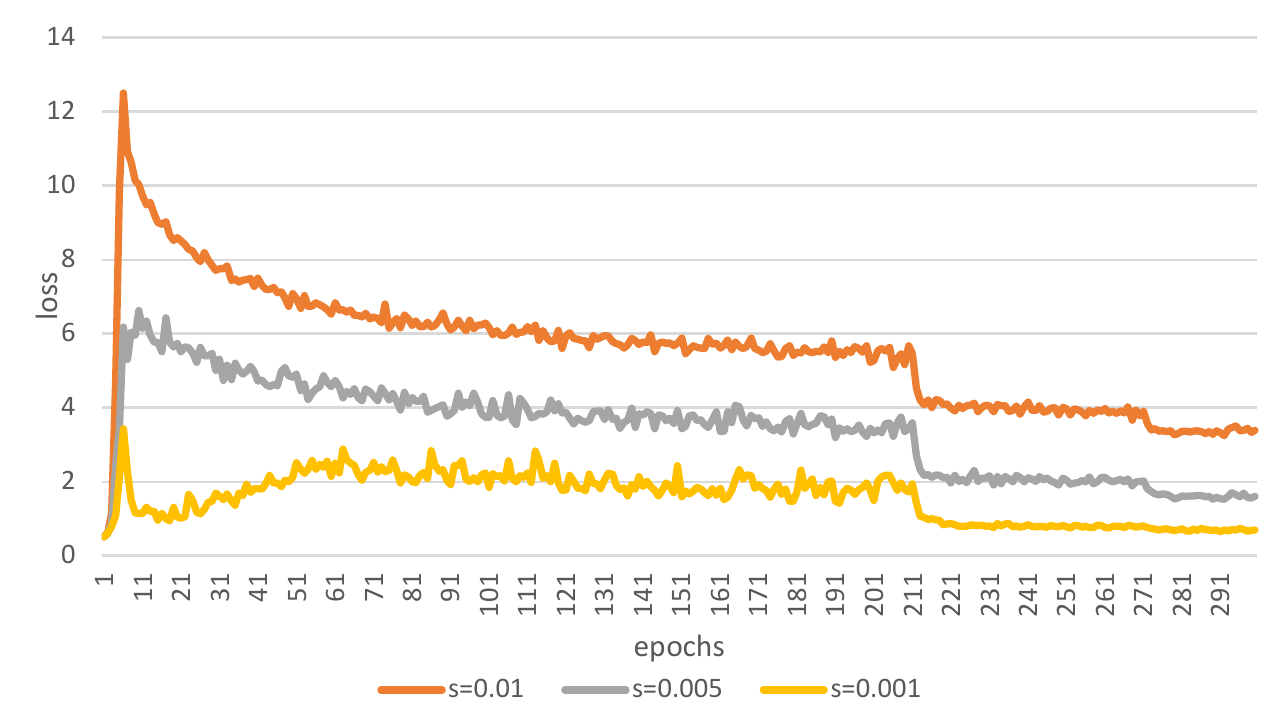
Figure 10. The loss curve for sparsity training with different sparsity factors.